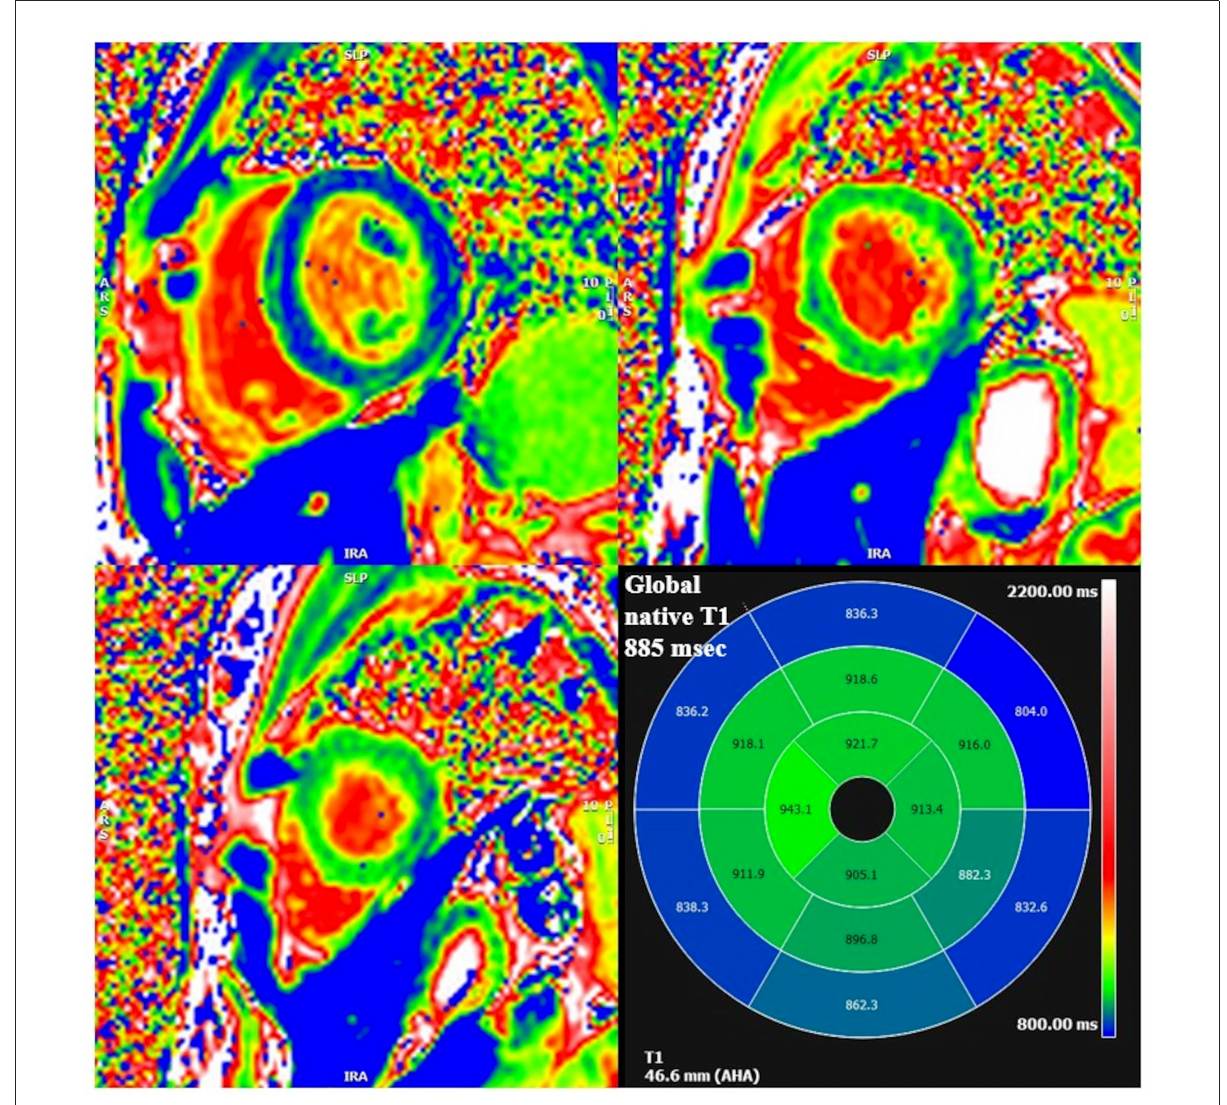
FIGURE3 Segmental and global low native T1 mapping at MOLLI images. On the bottom right square, AHA segmentation with T1 native values of each segment. Areas of low native T1 are highlighted in